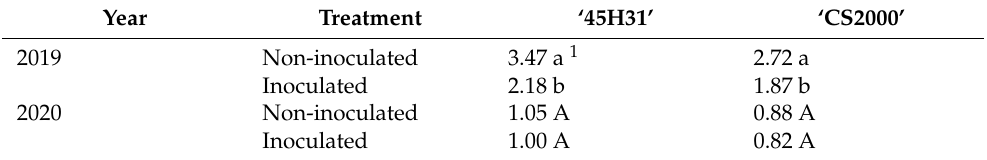
y ( ʹ 45H31 ʹ ) = − 1.767x 2 – 65.456x + 419.093; R² = 0.97 y ( ʹ CS2000 ʹ ) = 2.721x 2 – 92.035x + 454.402 ; R² = 0.69